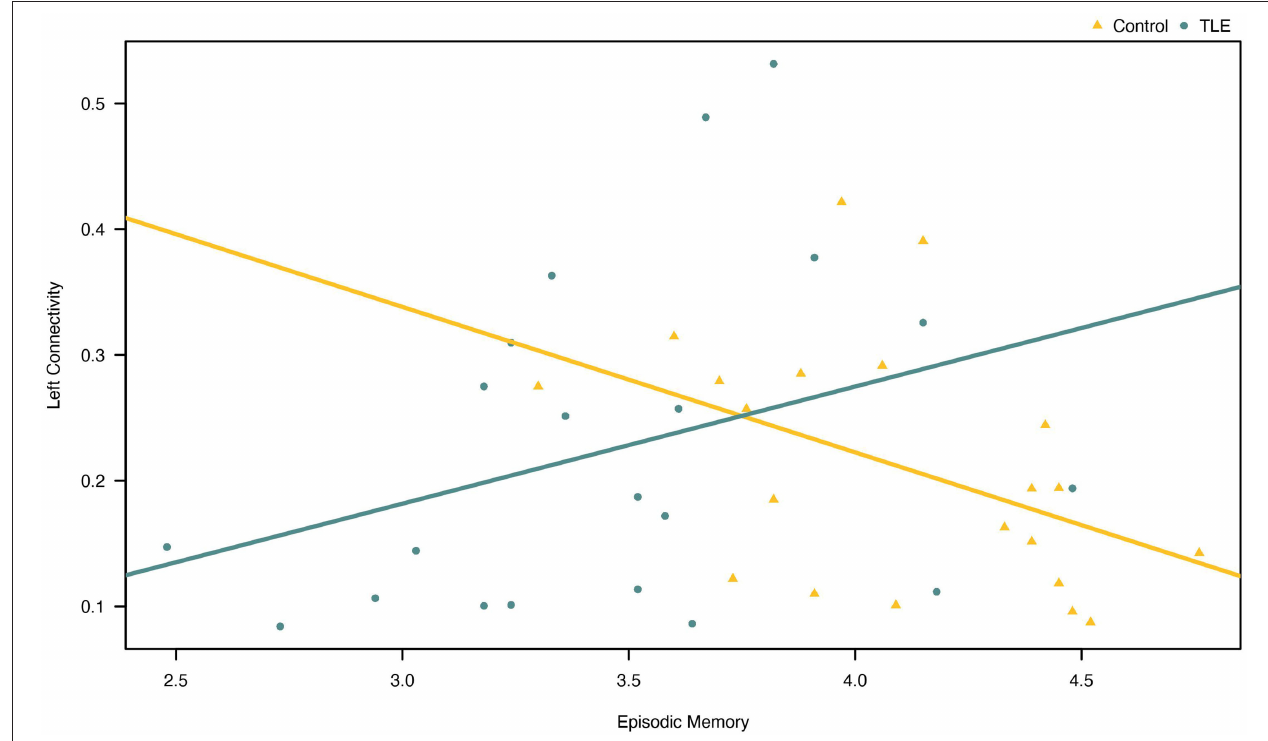
FIGURE 3 | Association between episodic memory and effective connectivity in the left parietofrontal in patients and controls. Note that the correlation was only (barely) statistically significant for the controls (yellow